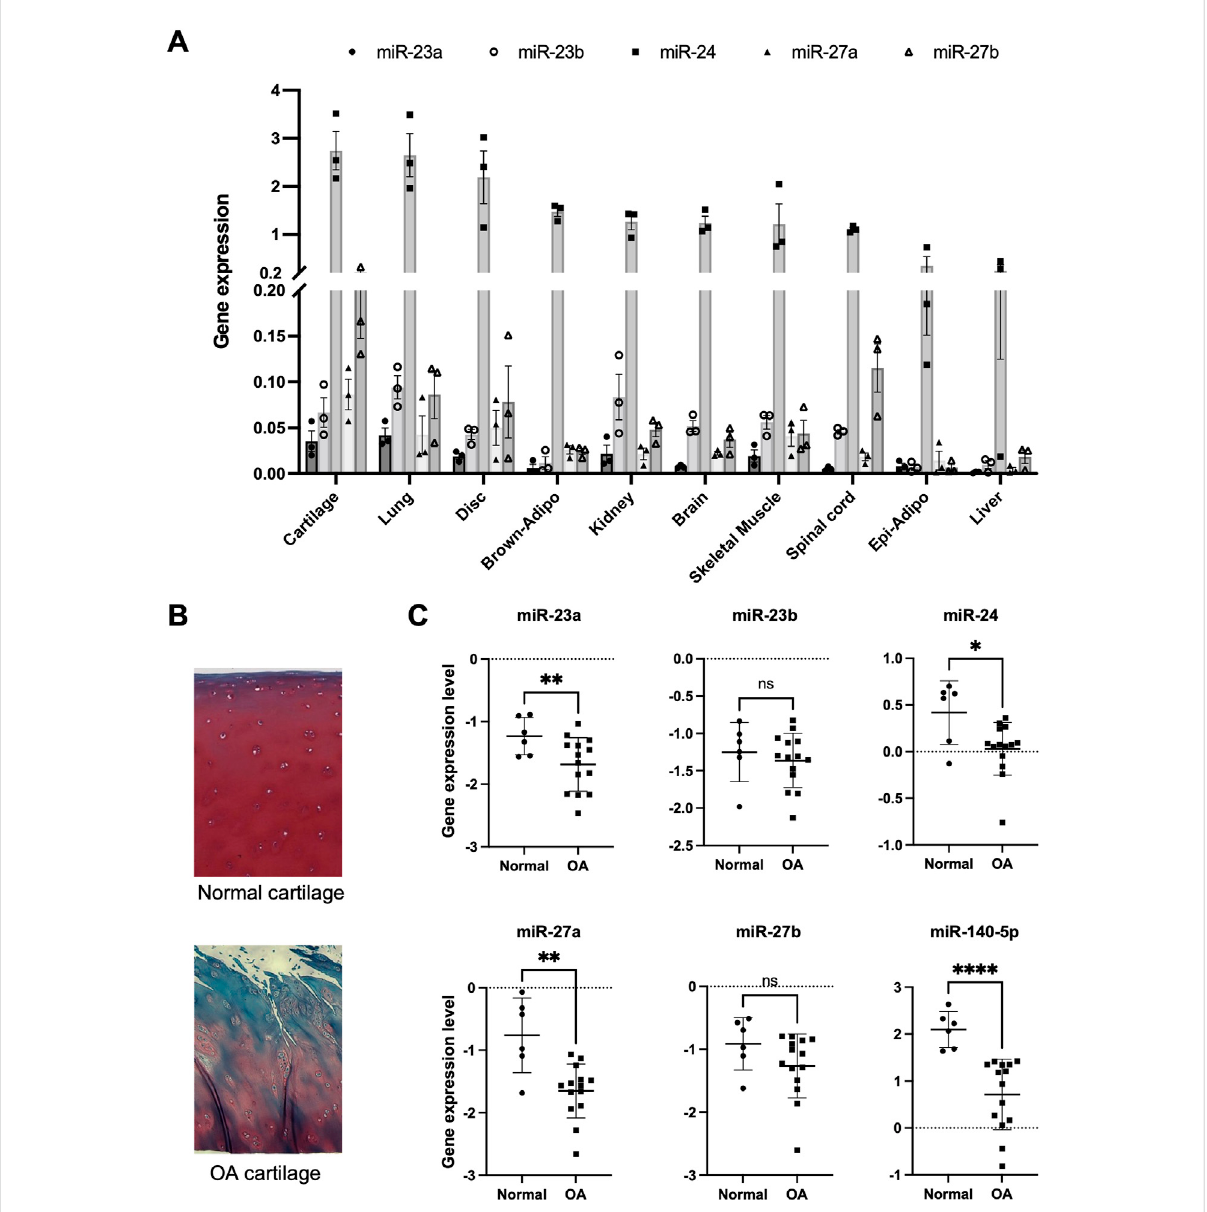
FIGURE 1 Expression pattern ofmiR-23a/bclustersin various tissues and osteoarthritiscartilage. (A) miR-23a/b clusters wereexpressedin various tissues (Cartilage: articular cartilage, Lung, Disc: intervertebral disc, Brown-Adipo: brown adipose tissue, Kidney, Brain, Skeletal muscle, Spinal cord, Epi- Adipo: epididymal adipose tissue, and Liver: n = 3 each tissue) of C57BL6/J mice at 4 weeks of age by real-time PCR analysis. (B) Normal human cartilageandOAcartilageforIsolationofArticularchondrocytes.RepresentativehistologicalimagewithSafranin-Ostaining. (C) Theexpression of miR-23a/b clusters and miR-140 in articular chondrocytes from human normalcartilage ( n = 6) and OA cartilage ( n = 14). All data are represented as mean ± SEM. Comparison of mean values was performed by Welch ’ s t -test; * p < .05, ** p < .01, **** p < .0001 versus normal chondrocytes. n. s: non-signi fi cant